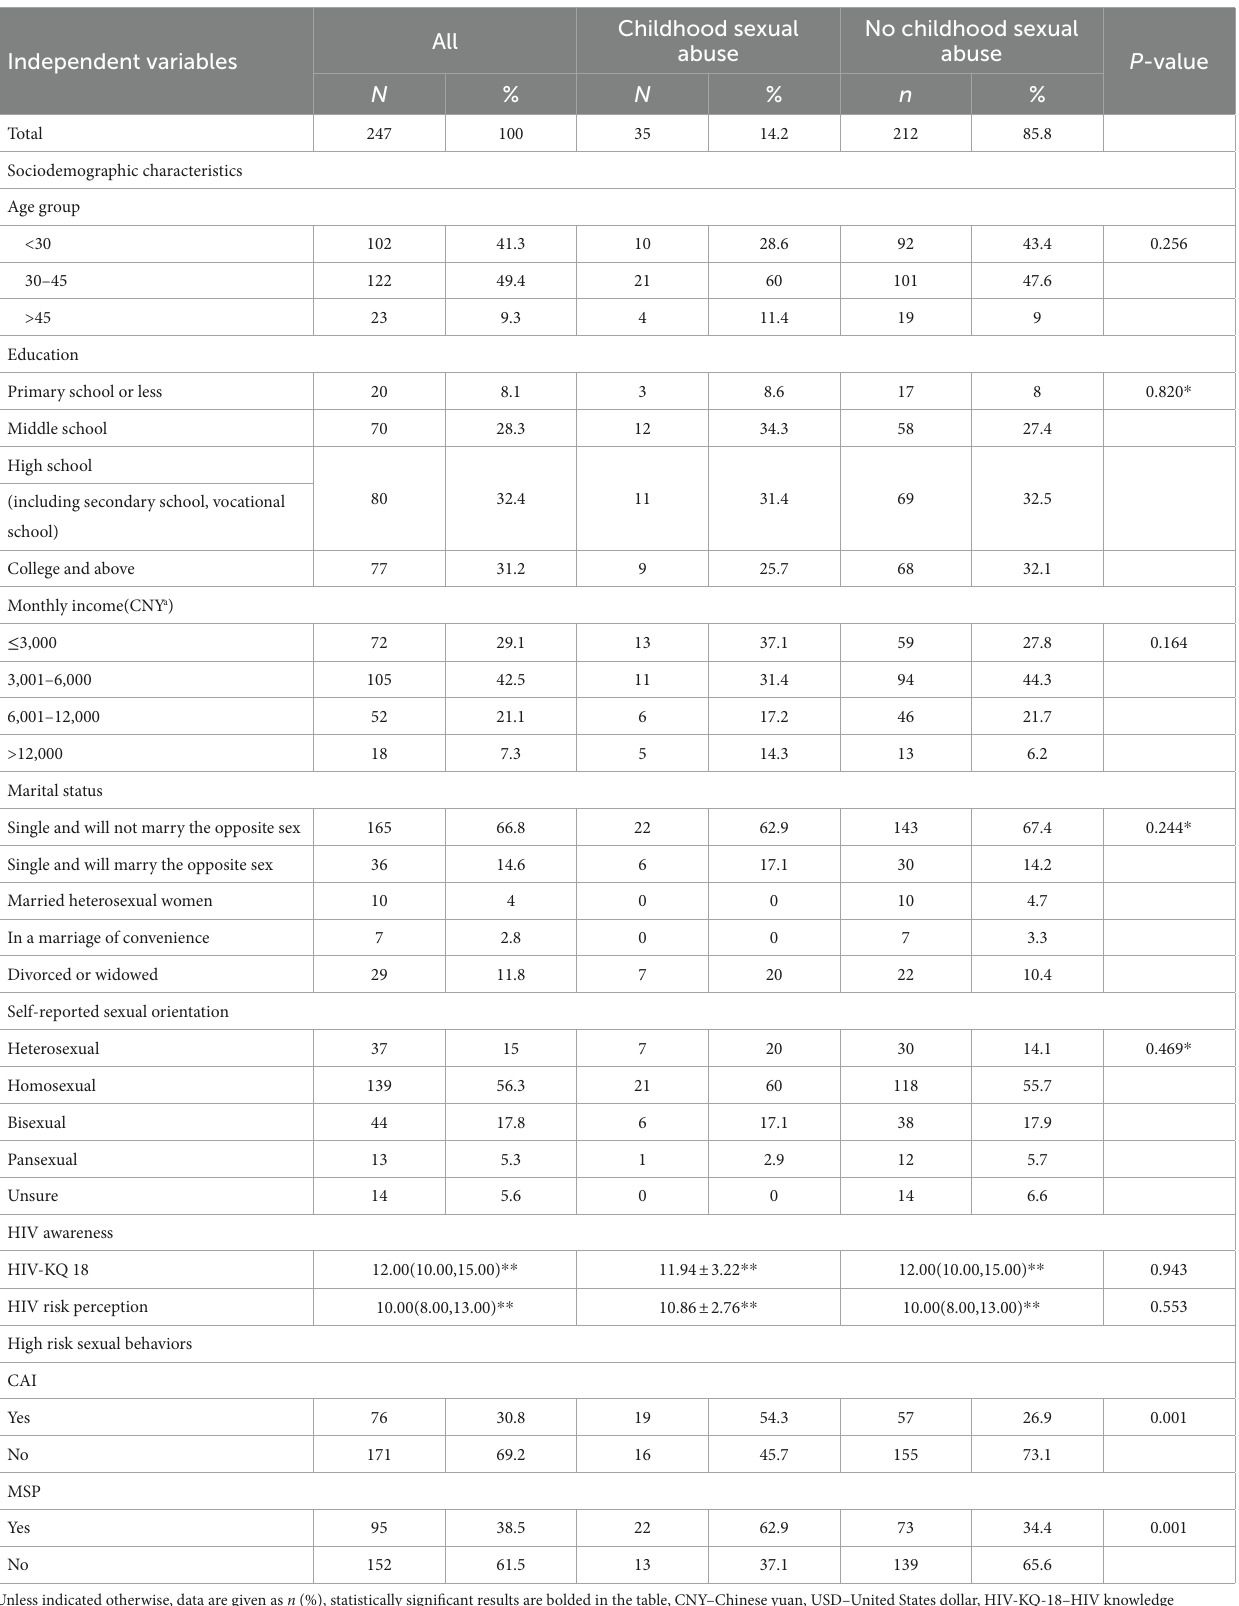
TABLE 1 Characteristics of transgender women by childhood sexual abuse in China.